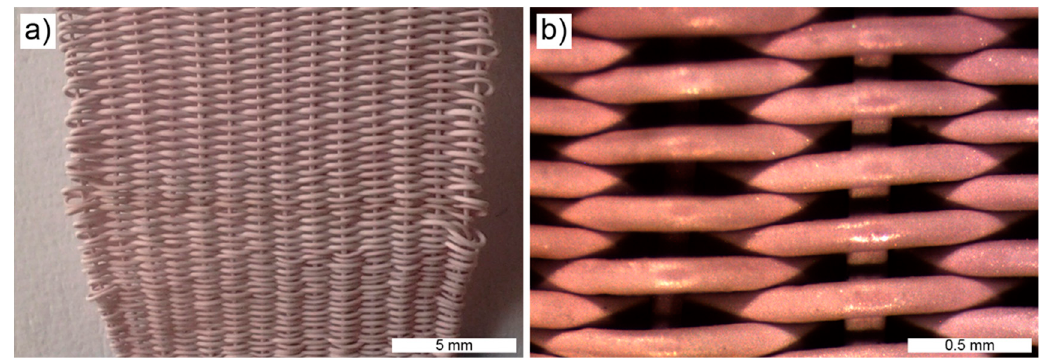
Figure 5. ( a ) Knitted fabric of gel-spun fibers of an UHMWPE–[Fe(NH 2 trz) 3 ](2ns) 2 blend with ~33.3% m / m [Fe(NH 2 trz 3 )](2ns) 2 (scale bar 5 mm). ( b ) Magnification of a part of the fabric (scale bar 0.5 mm).